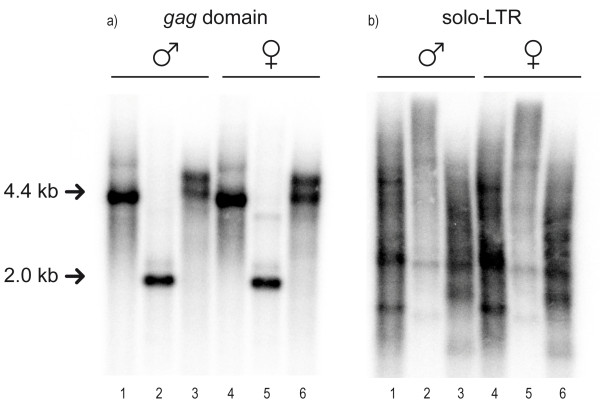
Southern blots of male and female Bryonia dioica. Southern blots using (a) the gag domain of the Copia-like sequence and (b) the solo-LTR as probes against male (lanes 1-3) and female (lanes 4-6) genomic DNA of Bryonia dioica. Restriction enzymes used were HindIII (lanes 1 and 4), EcoRI (lanes 2 and 5), and HaeIII (lanes 3 and 6).